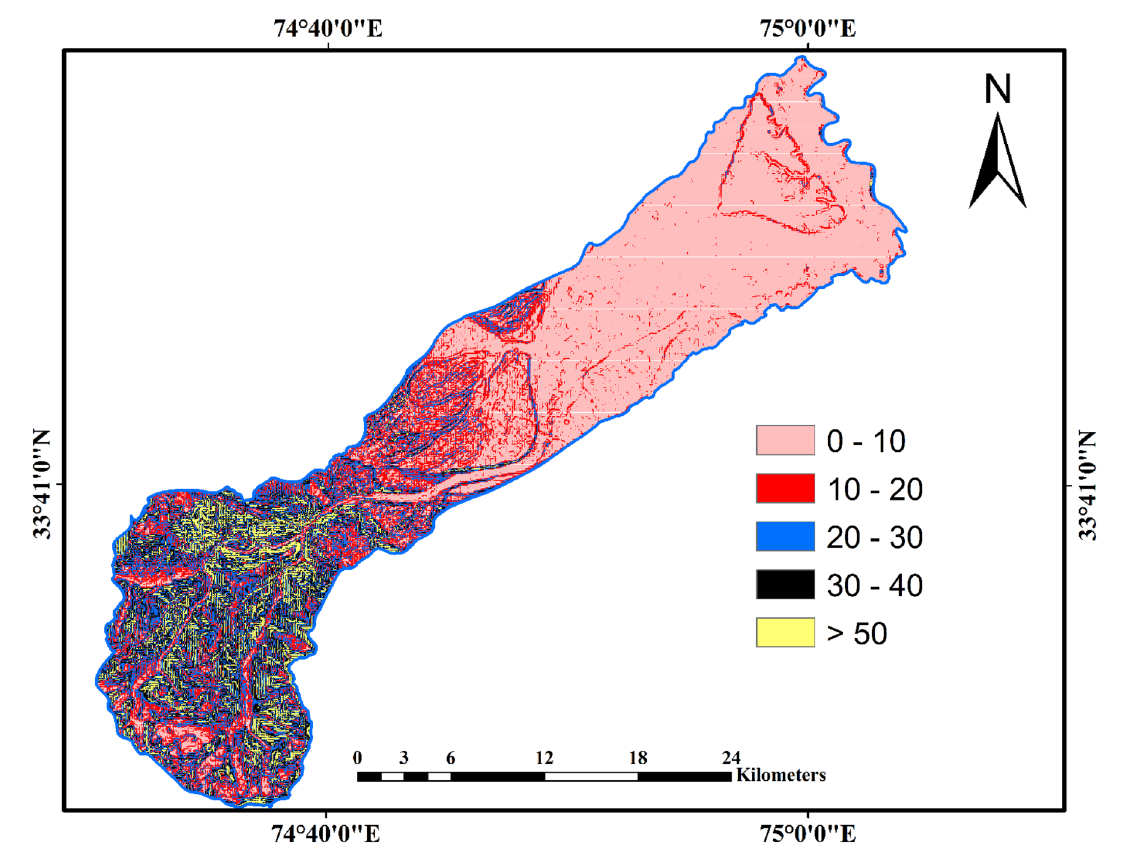
Fig. 8 Slope aspect map of the study